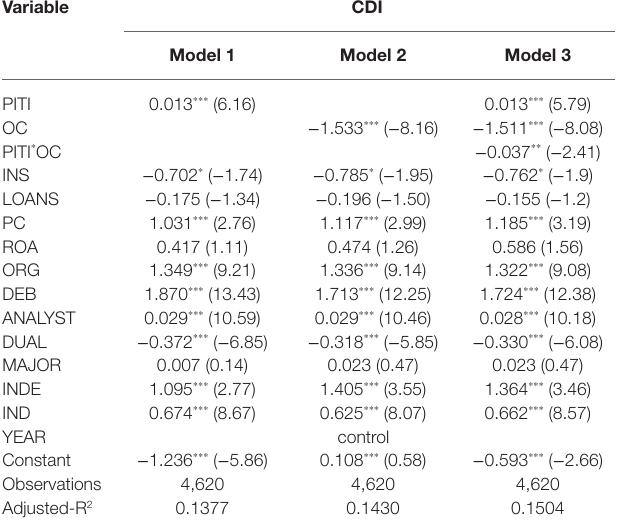
TABLE 7 | Multiple regression results.